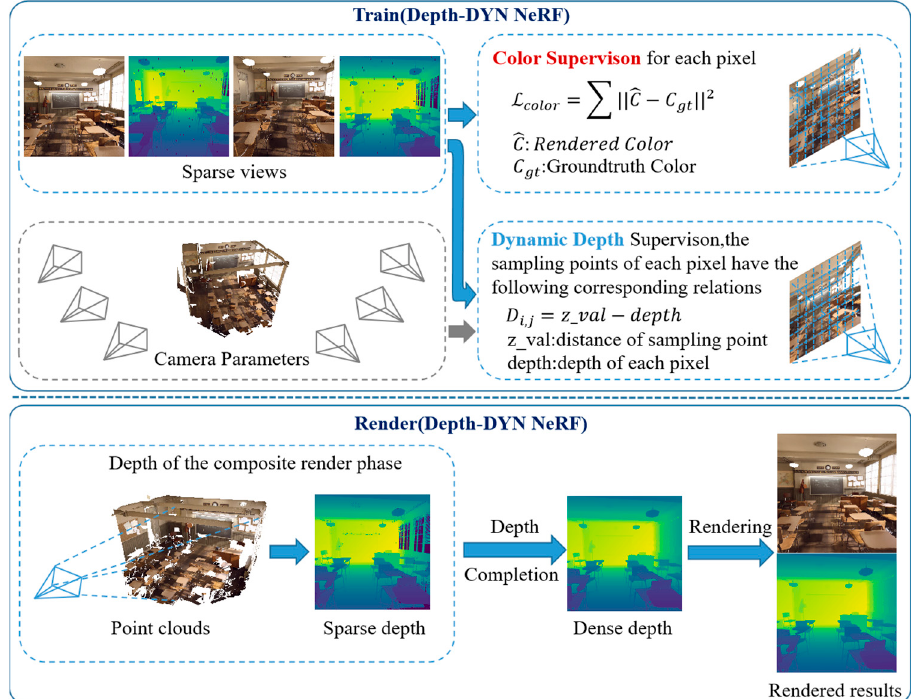
Figure 3. When there are few input images, the training NeRF may yield incorrect geometric structures. We use the depth information to add additional supervision to train NeRF so that each ray is sampled on the surface of the object. At the same time, we use the depth information to construct a 3D point cloud with the image, and, in the rendering stage, we obtain the depth information from the 3D point cloud to assist the rendering of NeRF. Our method is an extension of NeRF, which can be applied to any such methods.